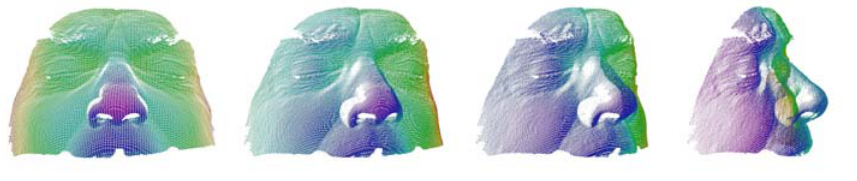
Fig. 2 Laser surface scan of the face, displayed from various view.